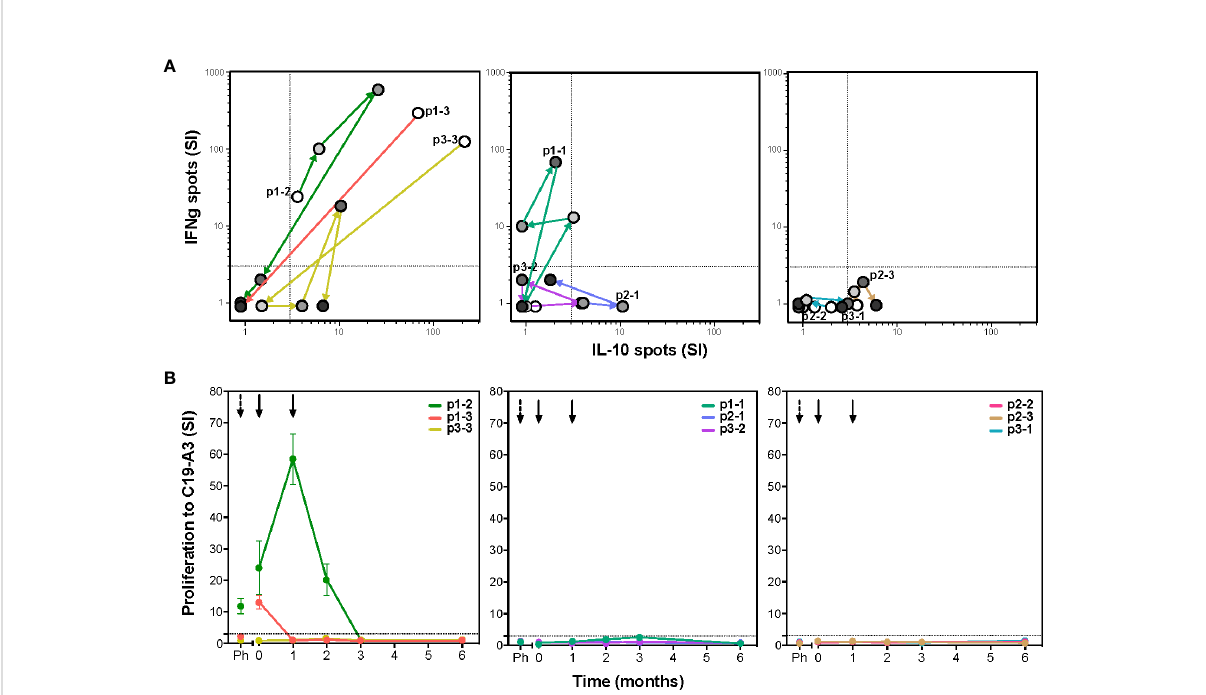
FIGURE 1 TolDC therapy modulates T-cell responses to the vaccine peptide (C19-A3) (A) The C19-A3-speci fi c T-cells producing cytokines IFNg and IL-10 were quanti fi ed using the ELISPOT assay. Left graph shows changes in IFNg/IL-10 production in three patients (p1-2, p1-3 and p3-3) with detectable cytokine responses to C19-A3 prior to tolDC therapy. Middle graph shows responses in three patients (p1-1, p2-1 and p3-2) with a temporary cytokine production to C19-A3 and right graph shows responses in three patients (p2-2, p2-3 and p3-1) with very low responses to C19-A3 prior and after tolDC therapy. For each patient, white circles show the number of cytokine-producing cells prior to tolDC treatment, successive circles with increasing gray tones depict 1, 2, 3 and 6 months post-tolDC therapy values. Patients are coded according to the received tolDC dosage (p1-1 to p1-3 0.5x10 7 cells; p2-1 to p2-3 1x10 7 cells and p3-1 to p3-3 2x10 7 cells). (B) Proliferative response to C19-A3 as determined by the lymphocyte stimulation test (LST). Proliferation was measured in triplicate as counts per minute (CPM) in wells with